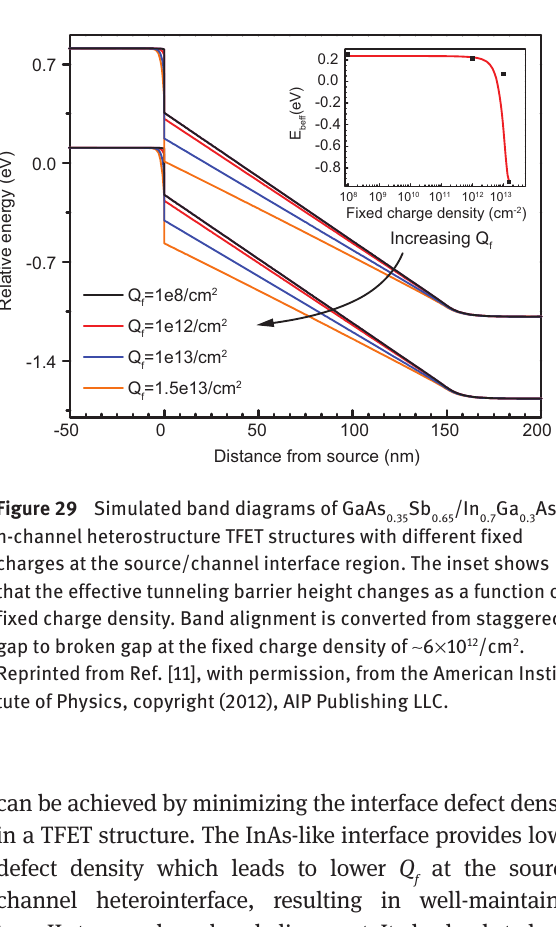
Figure 29 Simulated band diagrams of GaAs n-channel heterostructure TFET structures with different fixed charges at the source/channel interface region. The inset shows that the effective tunneling barrier height changes as a function of fixed charge density. Band alignment is converted from staggered gap to broken gap at the fixed charge density of ∼ 6 × 10 12 /cm 2